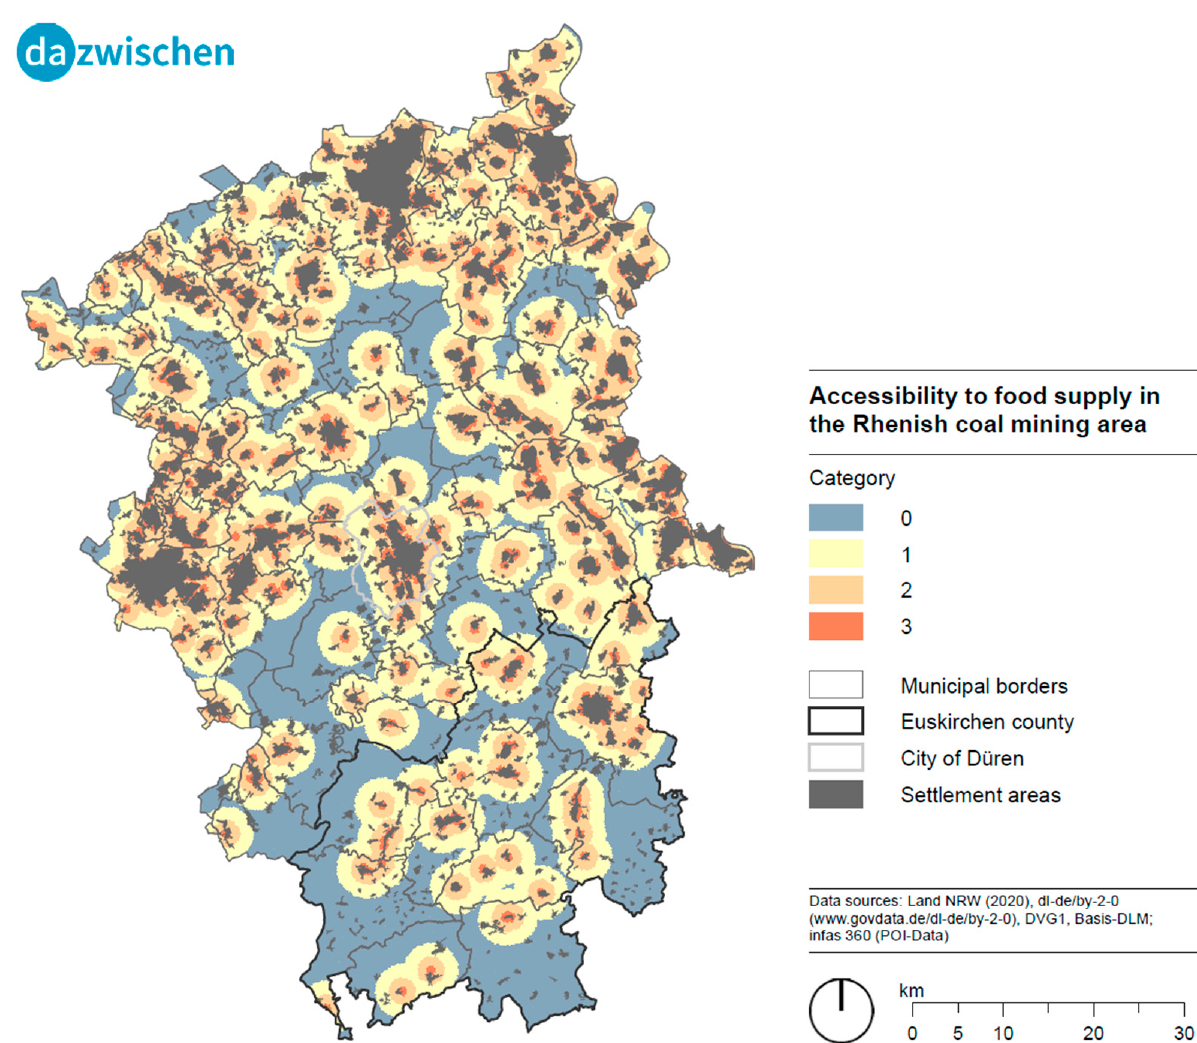
Figure 5. Accessibility to food supply. Source: own figure.